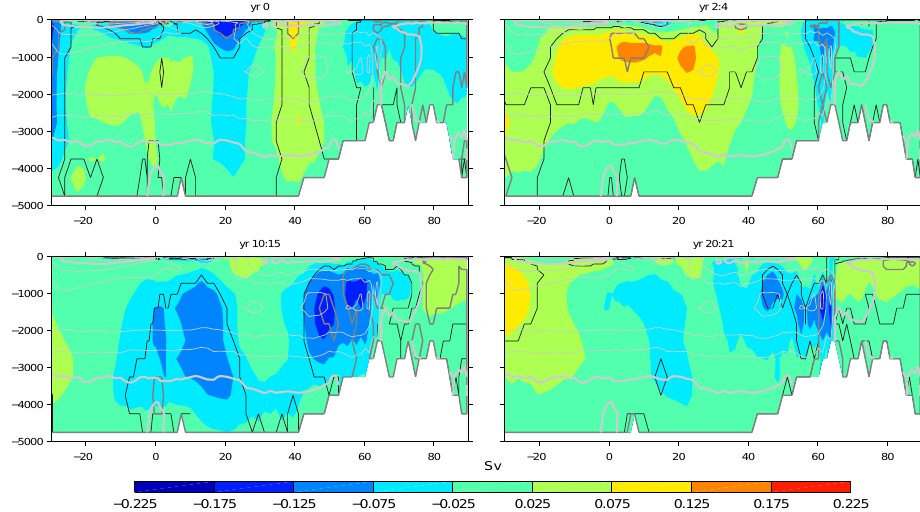
Fig. 15. As in Fig. 11 for the Atlantic meridional streamfunction during the period 1100–1300. Positive (negative) values correspond to a clockwise (counter-clockwise) circulation. Black and day grey contours mark significant areas at the 95% and 80% level, respectively, according to the Monte Carlo permutation test. Light grey contours show the annual mean Atlantic meridional circulation in the control simulation (contour interval is 3Sv, thick contour corresponding to the zero contour.)